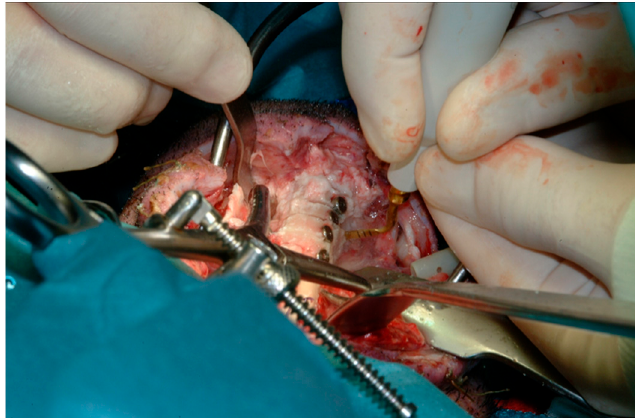
Figure 4. Sliced dissection using Piezosurgery.